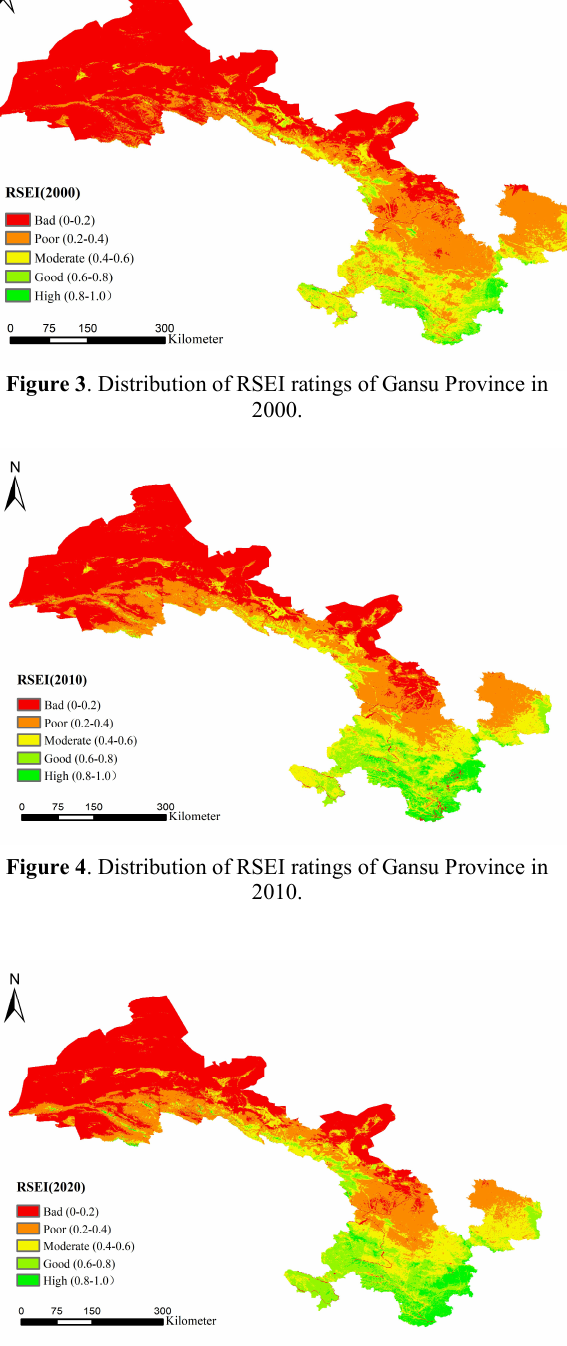
Figure 5 . Distribution of RSEI ratings of Gansu Province